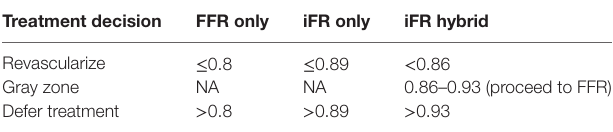
TaBle 1 | Fractional flow reserve (FFr) and instantaneous wave-free ratio (iFr) “cut-off” and “hybrid”